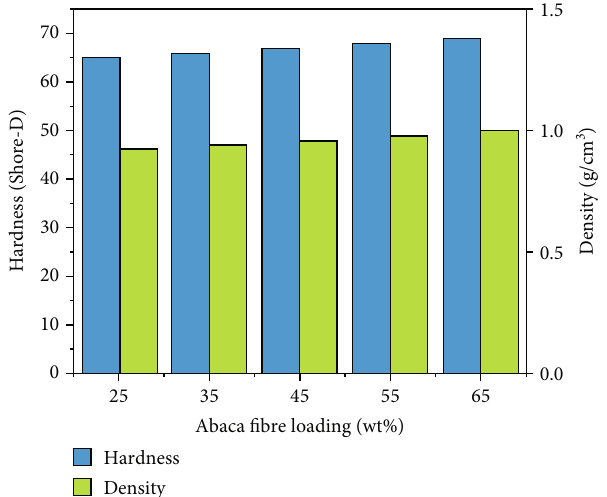
Figure 7: Surface hardness and mass density (g/cm 3 ) (wt